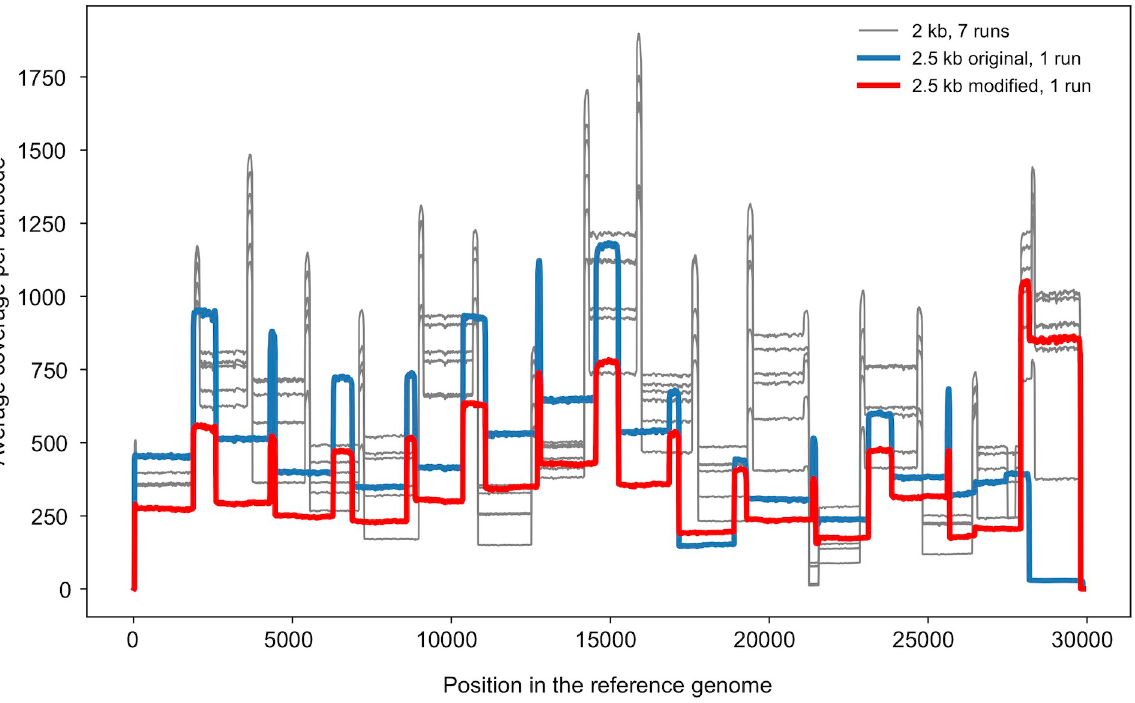
Fig 6. Genome coverage by long amplicons. Average coverage along the genome for seven runs with 2-kb amplicons (batches UKBA- 2,3,4,6,10,11,12) and two runs with 2.5-kb amplicons (UKBA-19 with the original primer set and UKBA-21 with the last primer pair replaced by its counterpart from the 2-kb scheme). Each line depicts the average coverage over all samples in a run at the time point when 40-Mbp per sample was sequenced on average. Medians of 50-bp windows are shown for smoothing. Note a drop-out in the amplicon 13 (2-kb scheme) which covers a 3’ end of orf1b and about a third of the S gene including the region associated with mutations in Variants of Concern such as B.1.1.7.